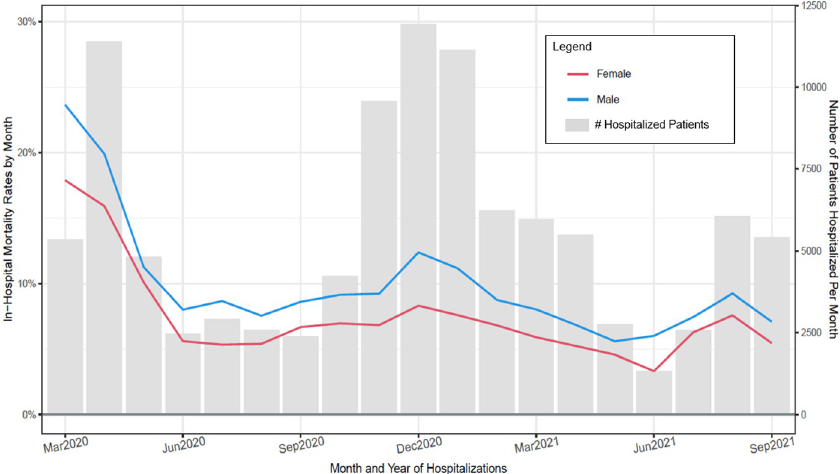
Fig 4. Observed in–hospital mortality rates (Deaths/hospitalizations) and number of patients hospitalized per month for patient sex groups (March 2020 through September